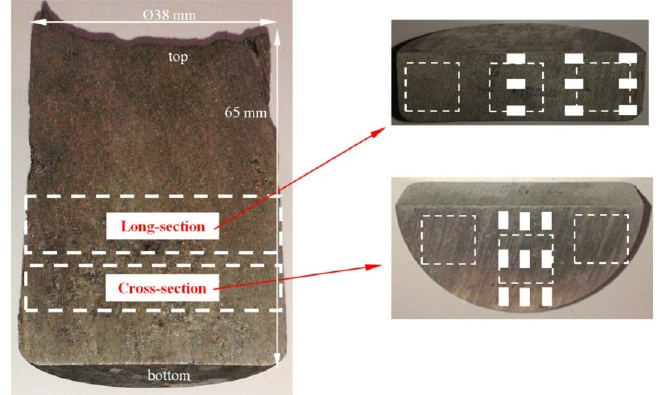
Figure 1. Scheme of cutting the long- and cross-section in the ingot specimen. The placement of the microstructure parameter (Table 1) measurement on the long- and cross-section. The white fulfilled rectangles show 18 (9 on cross- and 9 on long-section) areas for the parameter measurement (magnification 50× and 200×). The dashed line rectangles show 6 measurement regions magnified by 50×.